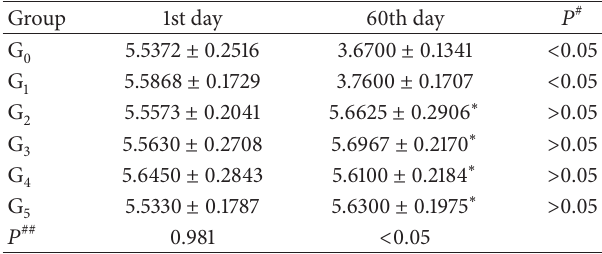
Table 1: Shear strengths of bone-bone cement interfaces (MPa) on the 1st day and 60th day after surgery in each group.